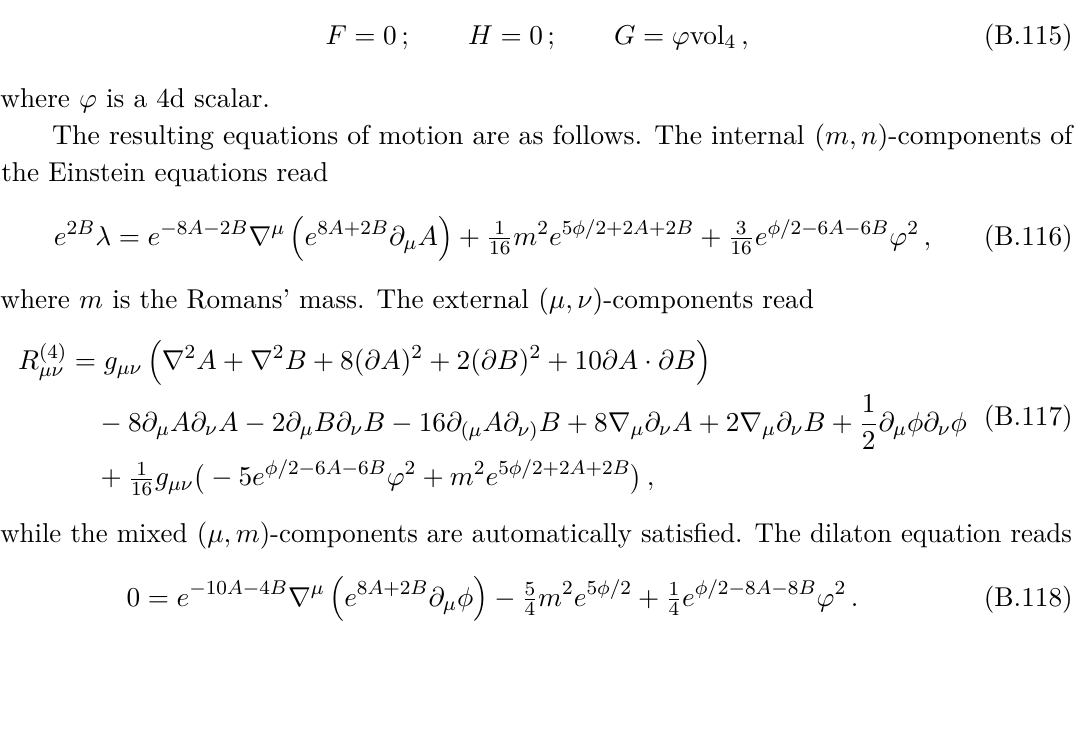
Figure 14 . Plot of